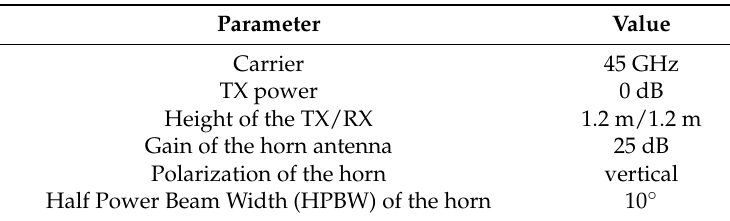
Table 1. Specification of the system.